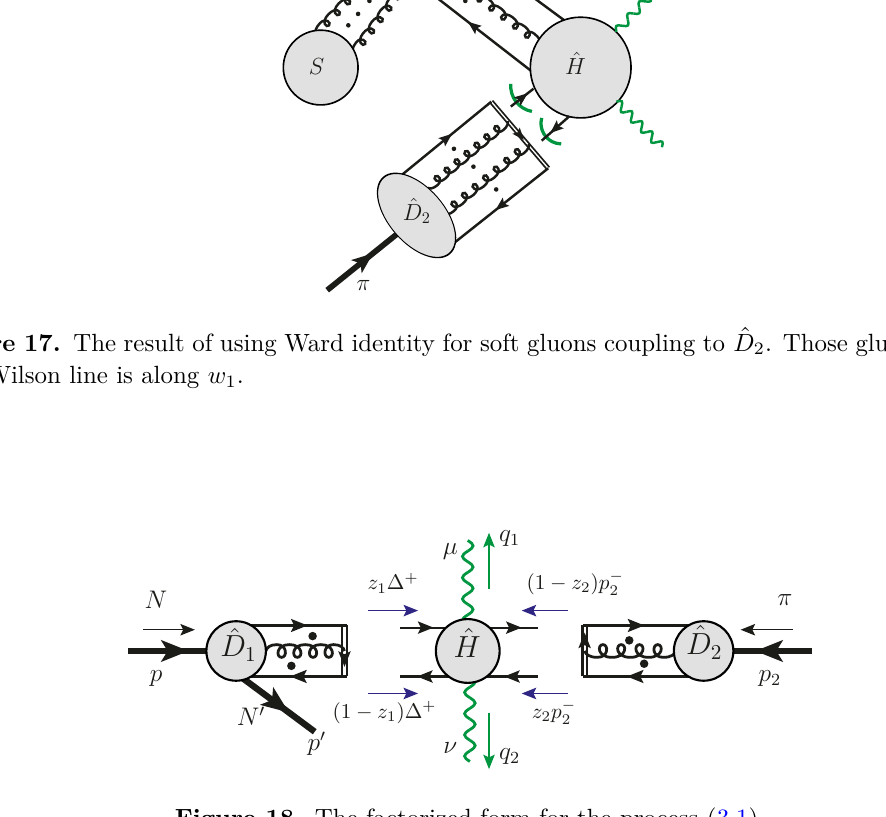
Figure 18. The factorized form for the process